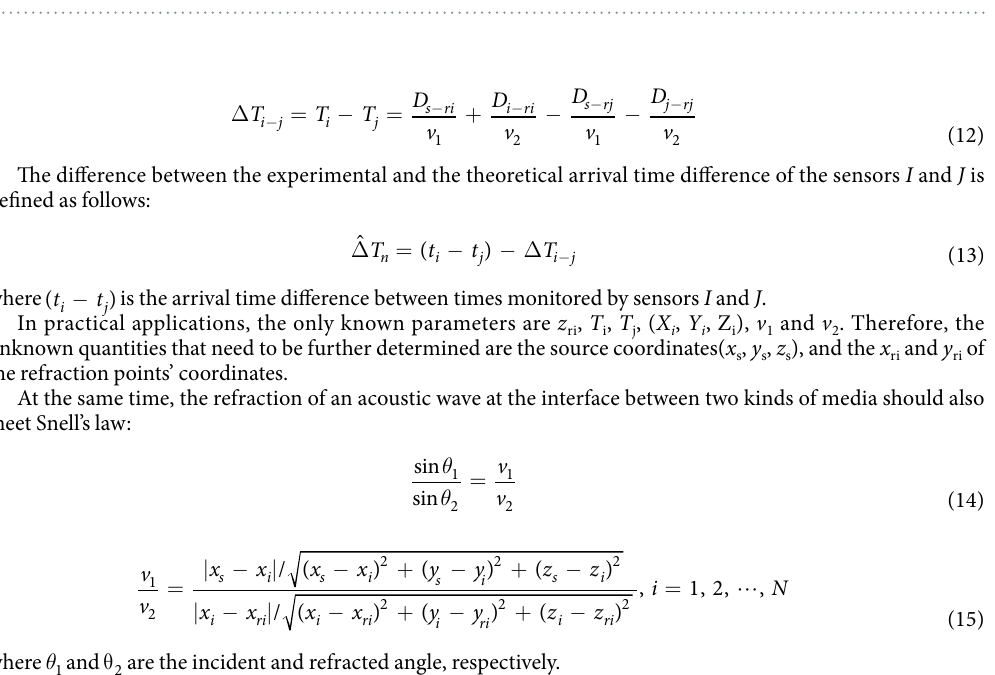
Figure 5. The propagation path of the 3D TDOA location method considering